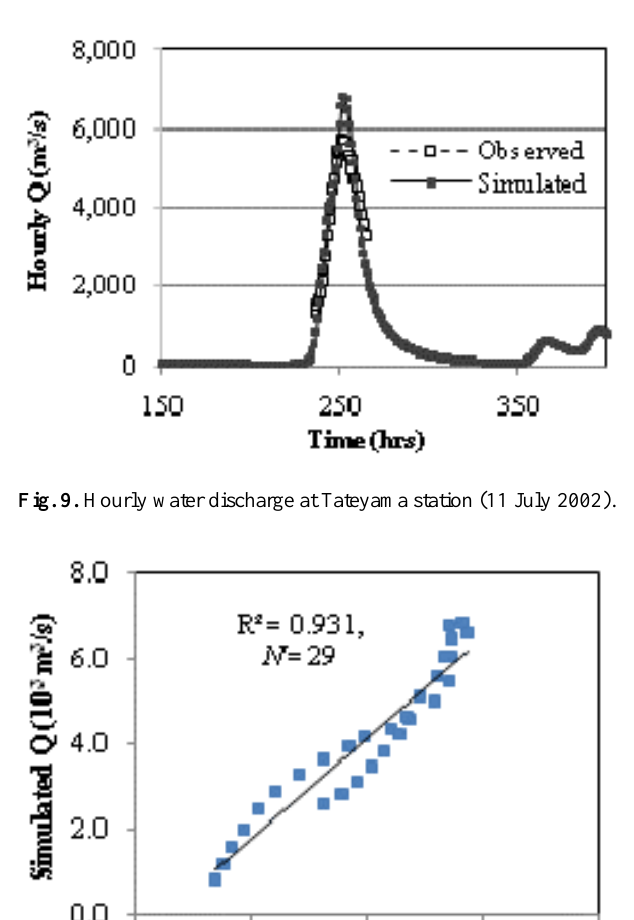
Page 9: Fig. 9. Hourly water discharge at Tateyama station (11 July 2002). Page 9: Fig. 10. Correlation of observed and simulated hourly water discharge at Tateyama (11 July 2002) ( N Fig. 9. Hourly water discharge at Tateyama station (11 July 2002). 1